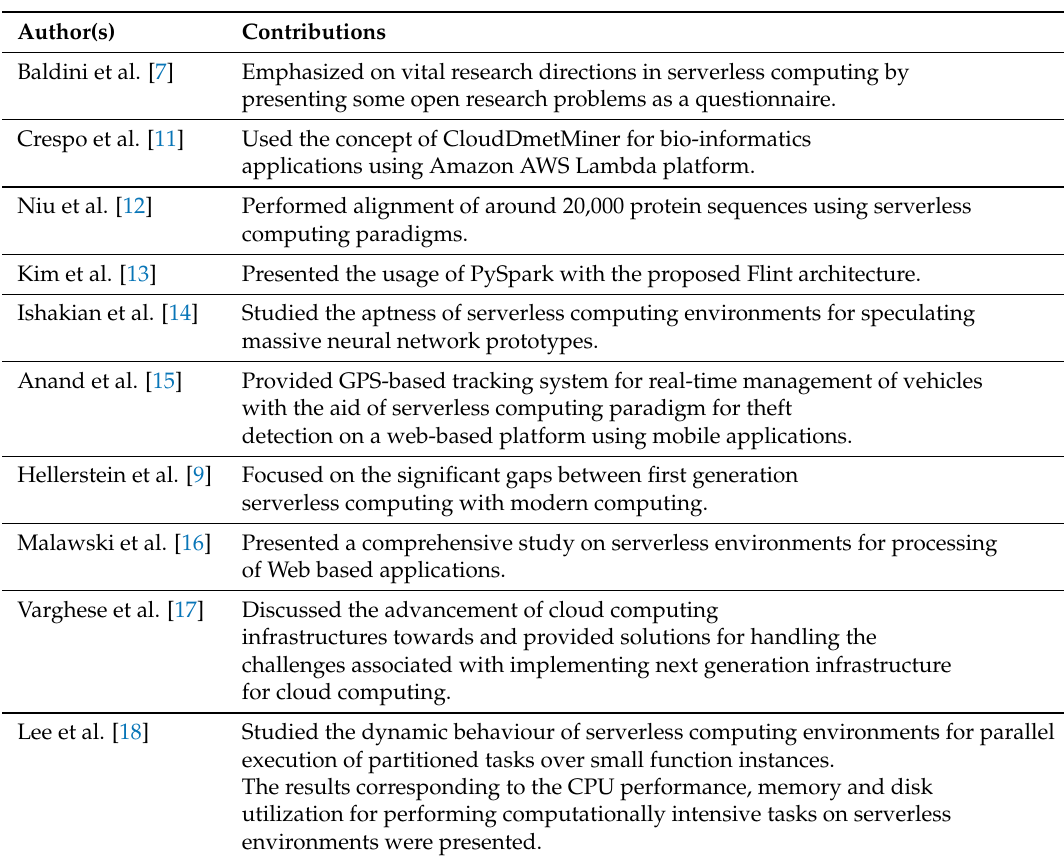
Table 1. A summary of some notable works, along with their contributions for assessing the capabilities of serverless